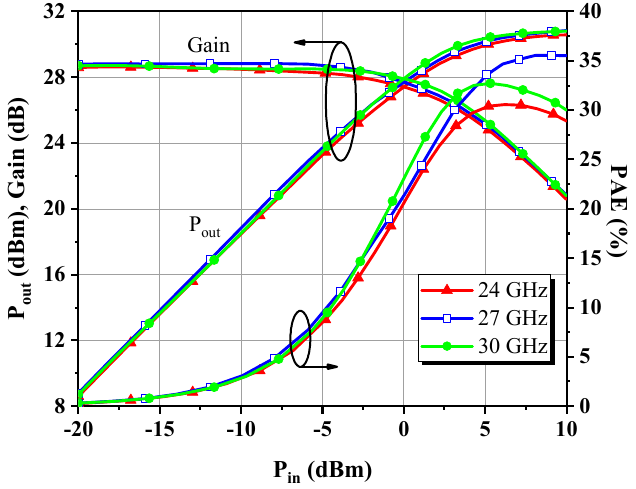
Figure 20. Measured P out , PAE, and gain behaviors with respect to input power at 24, 27, and 30 GHz.